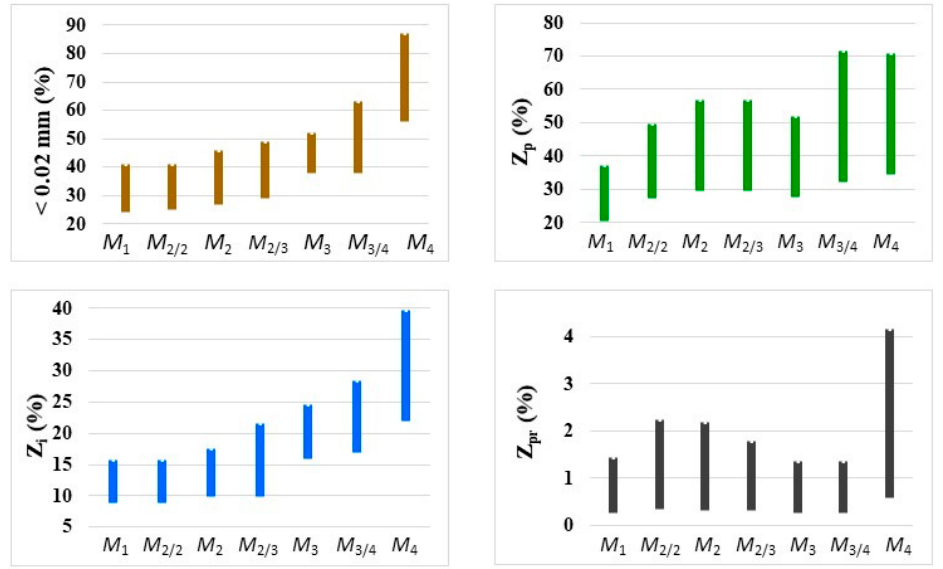
Figure 5. Ranges of selected soil parameter values for the particular data subsets (Mx) , obtained after grouping with combination number 9 (see Table 5): Designations: < 0.02, Z p and Z i –soil particle fraction content, respectively: < 0.02 mm, 0.05–0.002 mm and < 0.002 mm, Z pr –soil humus content.